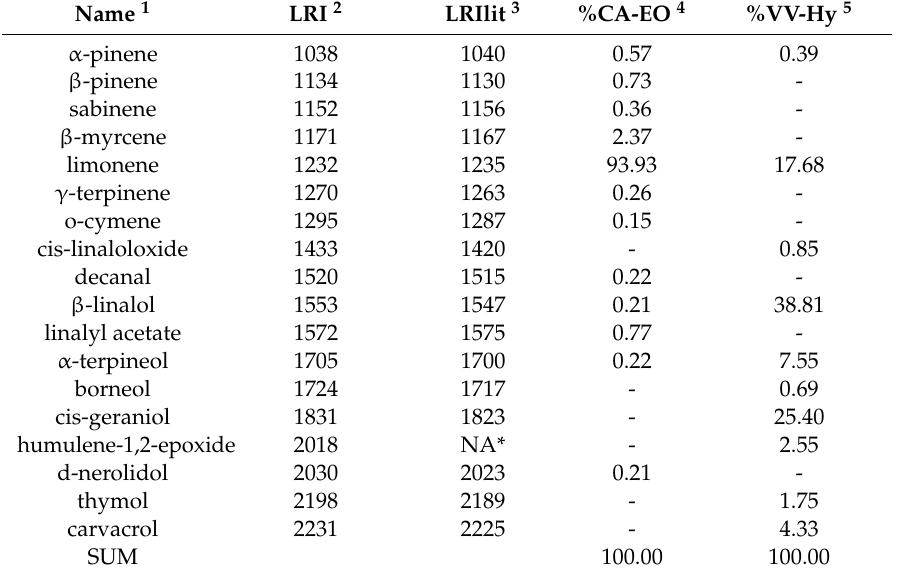
Table 5. Chemical composition (%) of C. aurantium var. amara EO and V. vinifera Hy.